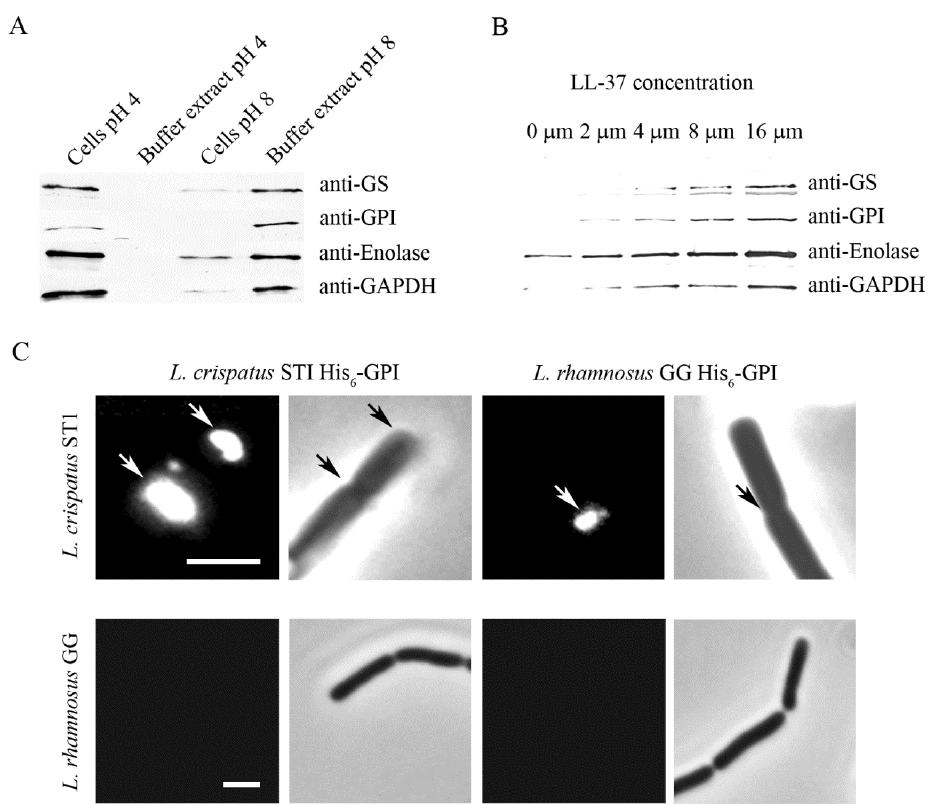
Figure 2. Release of moonlighting proteins from L. crispatus ST1 surface and reassociation of recombinant proteins onto the cell wall. ( A ) Western blotting of GS, GPI, enolase, and GAPDH from the surface of L. crispatus ST1 cells and from the cell-free buffer. The cells were incubated at pH 4 or pH 8 for 1 h, and the moonlighting proteins in neutralized samples were visualized by immunoblotting. ( B ) Release of moonlighting proteins in the presence of increasing concentrations of the cationic peptide